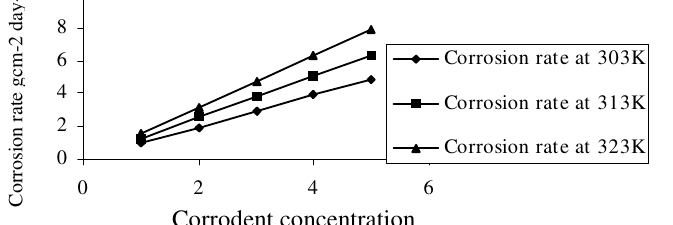
Figure 2. Variation of corrosion rate (gcm -2 day -1 ) with corrodent concentration (M) for mild steel coupons in HCl solution at different temperatures without